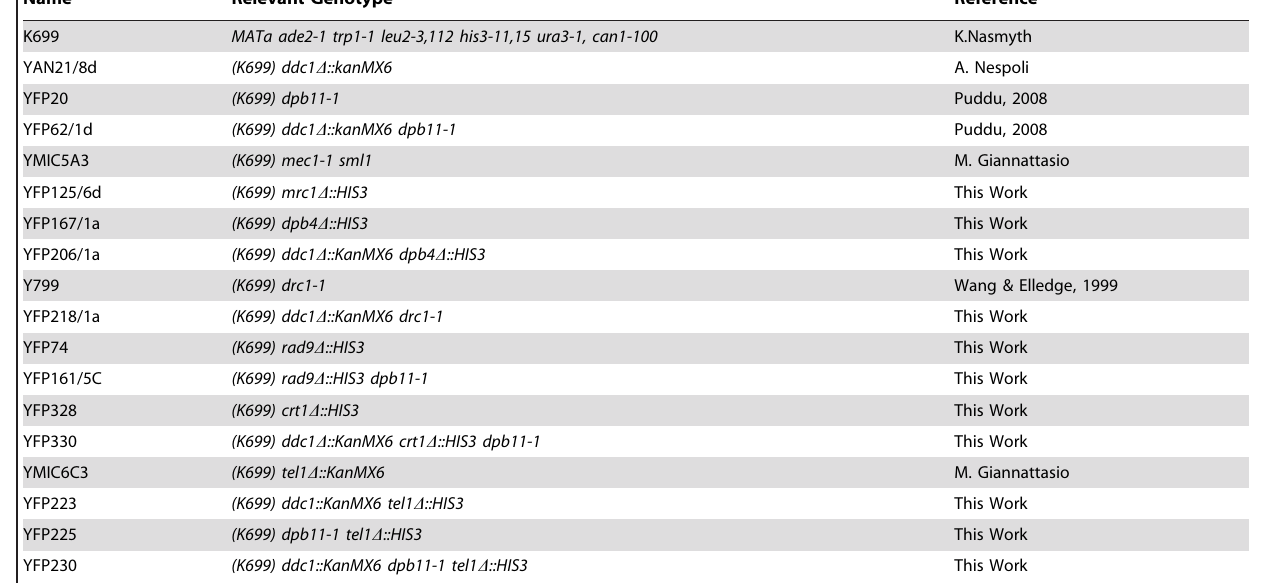
Table 1. Strains used in this